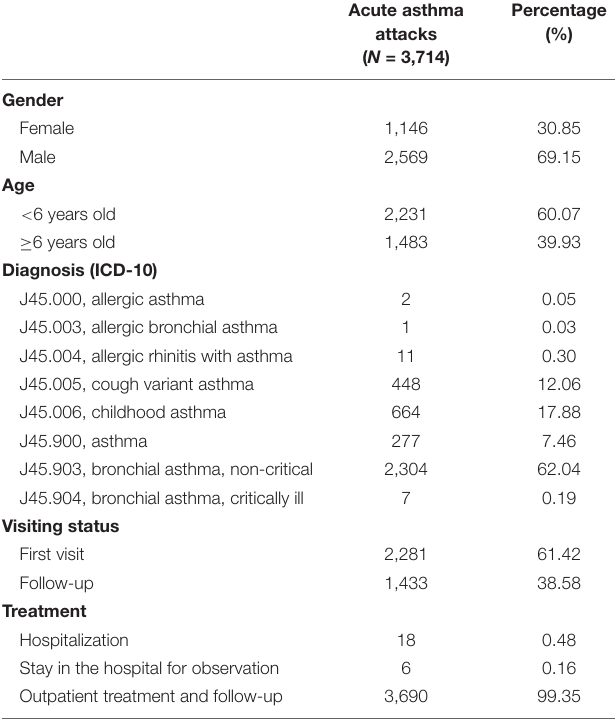
TABLE 1 | Characteristics of acute asthma attacks from 2016 to 2019.